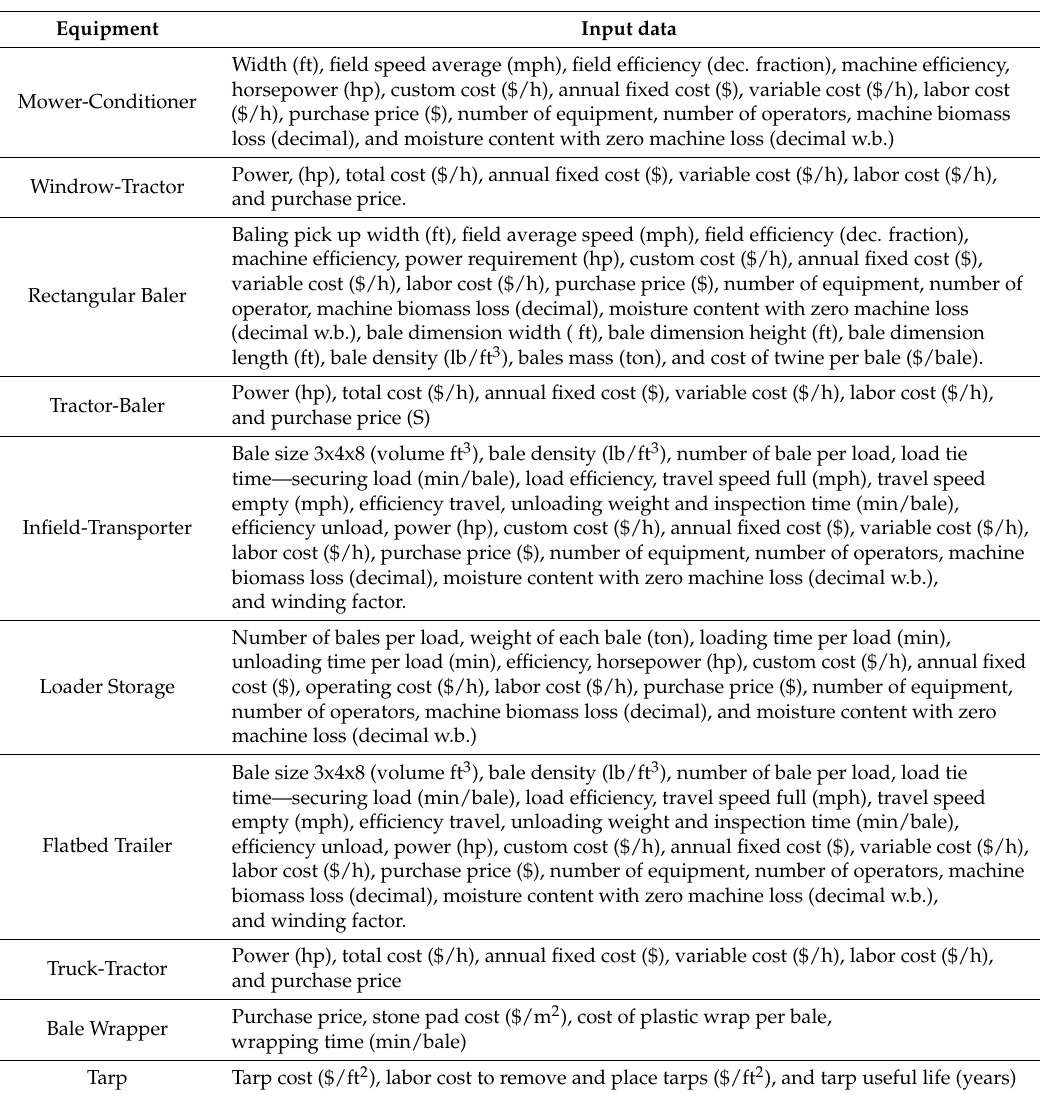
Table 2. Equipment input